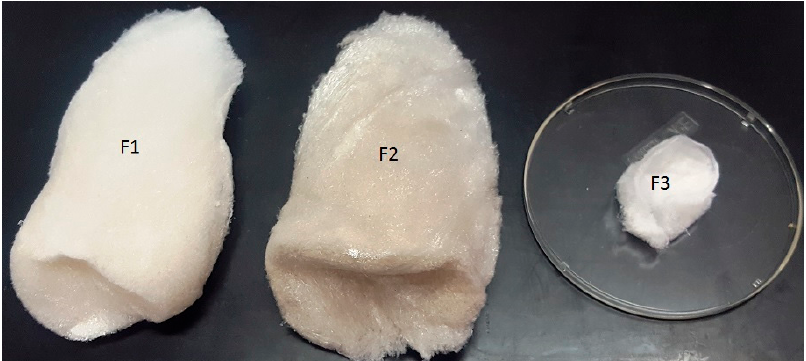
Figure 4. A representation of the three collagen fractions obtained from a mixture of M.merluccius skin and bones. ASC from the skin (F1), pepsin ‐ soluble collagen (PSC) from the skin (F2), and ASC and bones. ASC from the skin (F1), pepsin-soluble collagen (PSC) from the skin (F2), and ASC from the from the bone (F3). bone